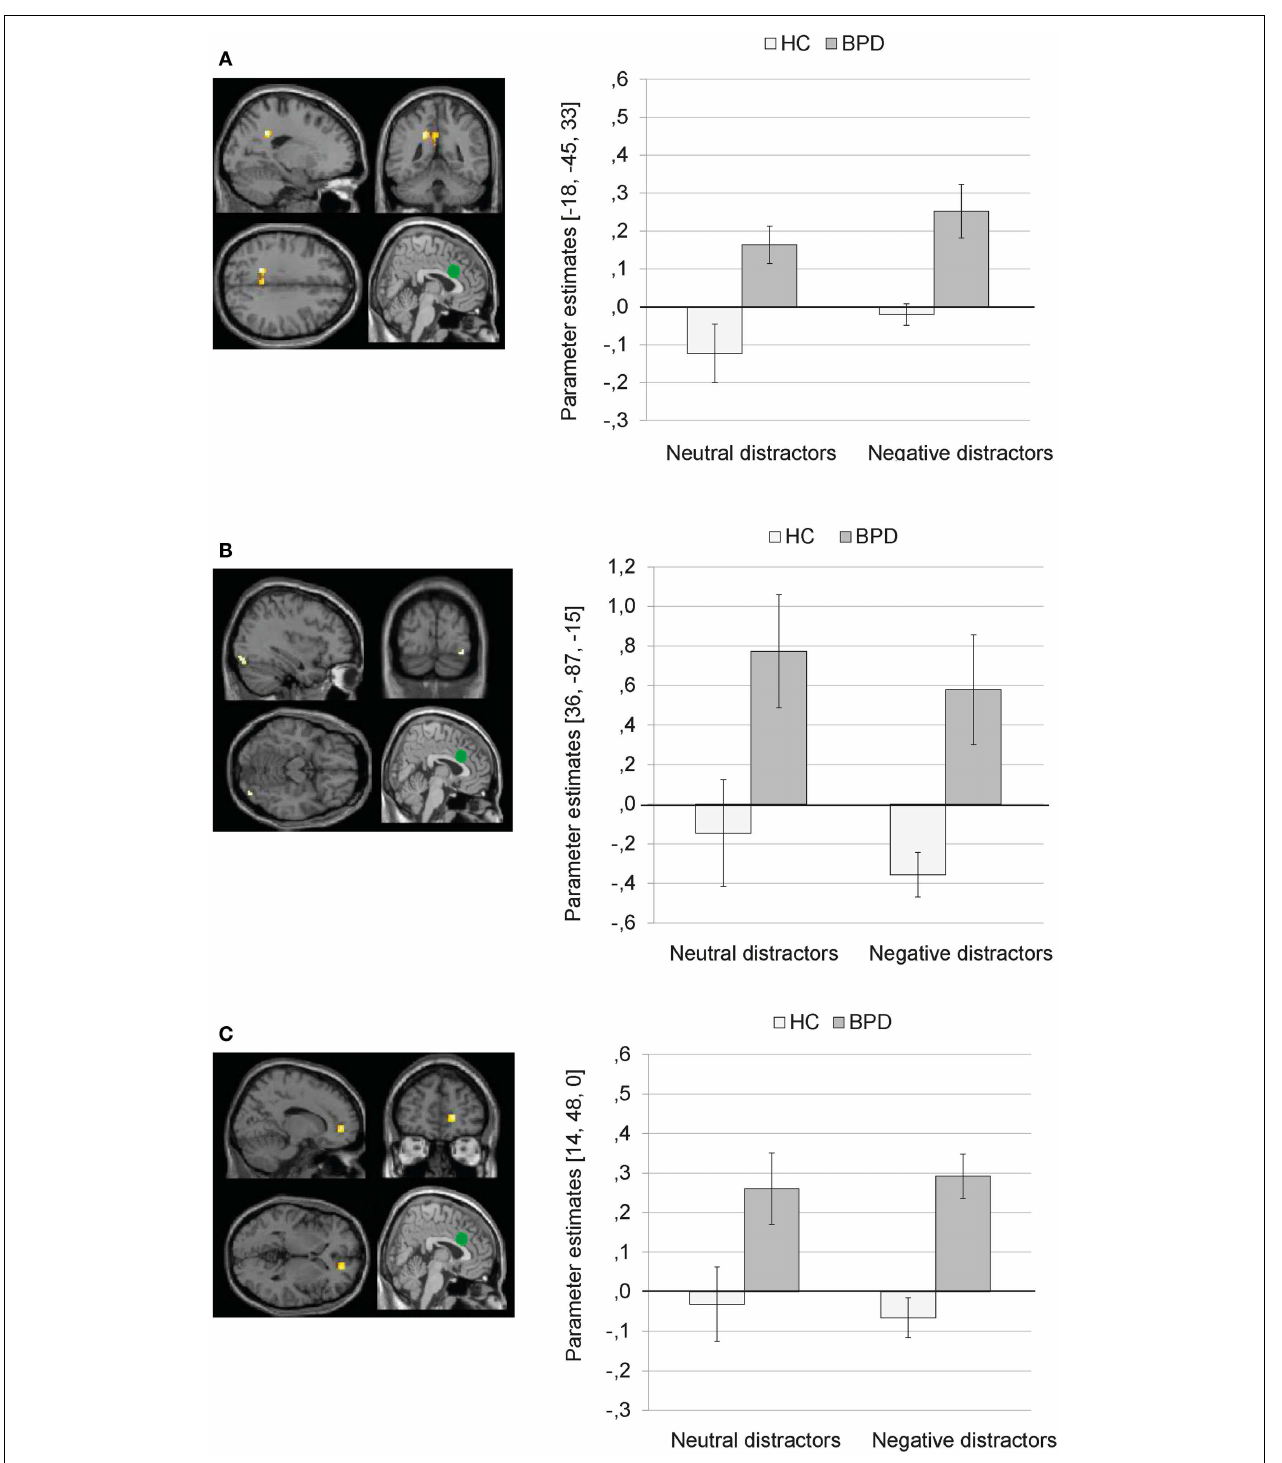
FIGURE 5 | Means ± standard errors of the mean (SEM) of parameter estimates for connectivity of the bilateral dorsal anterior cingulate (dACC) seed (depicted in green) during presentation of neutral distractors and negative distractors in patients with borderline personality disorder